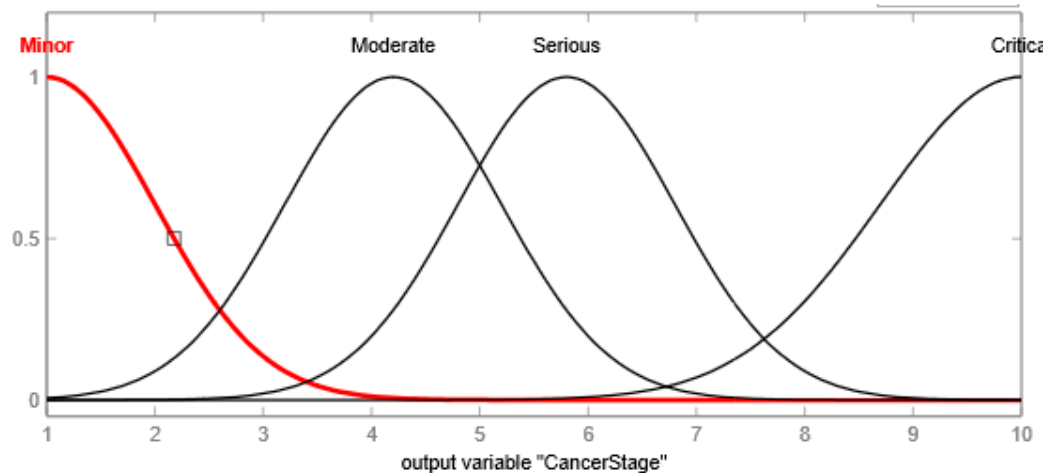
Figure 7. Membership function of output variable “Layer 2”.